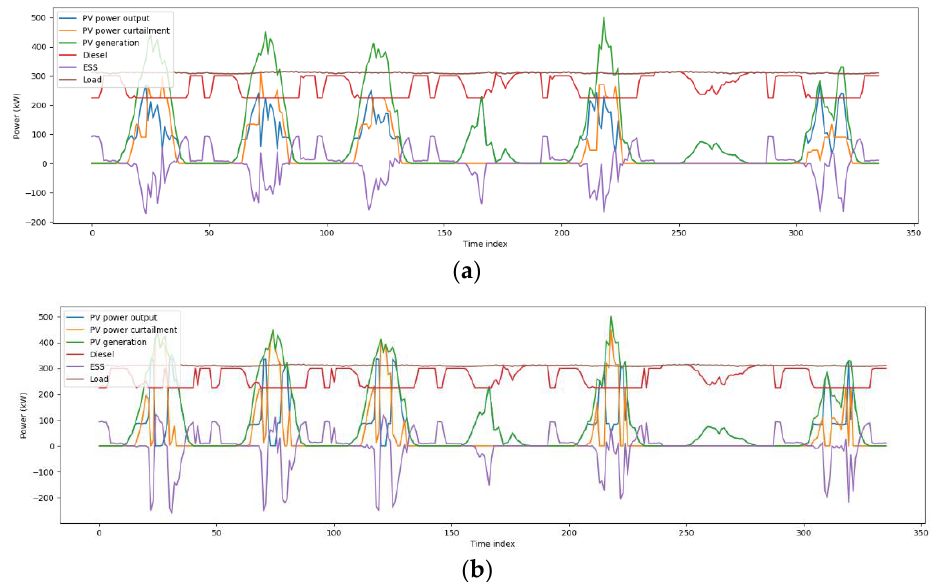
Figure 8. Simulation results of proposed method ( a ) and conventional method ( b ) for 7 days of